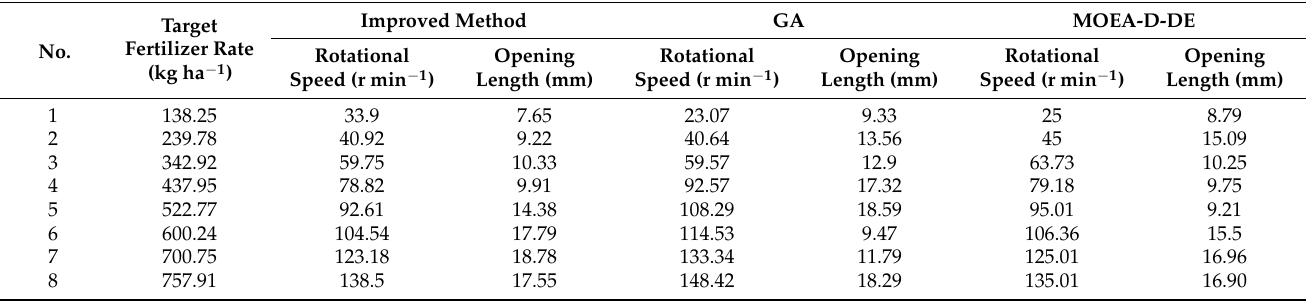
Table 10. Fertilization decisions acquired by the three methods for different target fertilization